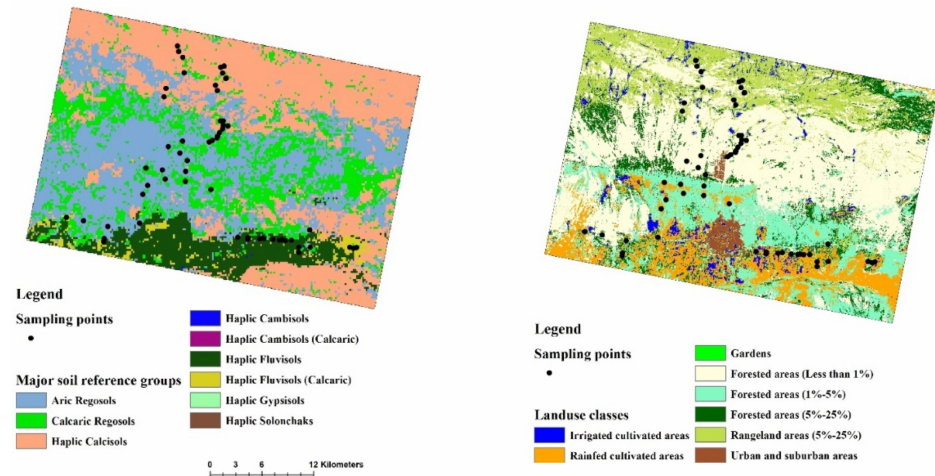
Figure 2. Major soil reference groups and land-use classes of the study area and the location of the point samples on di ff erent land-use types. Precision separation of irrigated and rainfed areas might be under bias (For more details